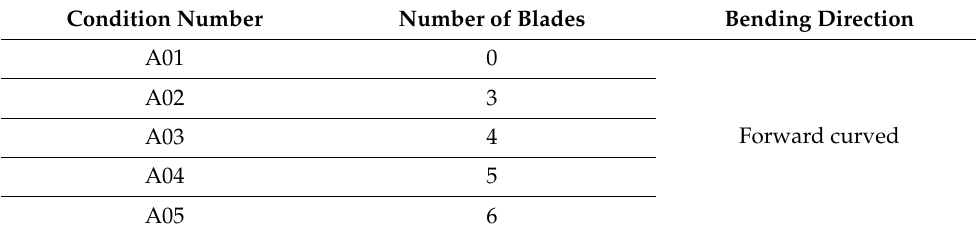
Table 3. Experimental setting of optimization of number of fan blades. Condition Number Number of Blades Bending Direction 0